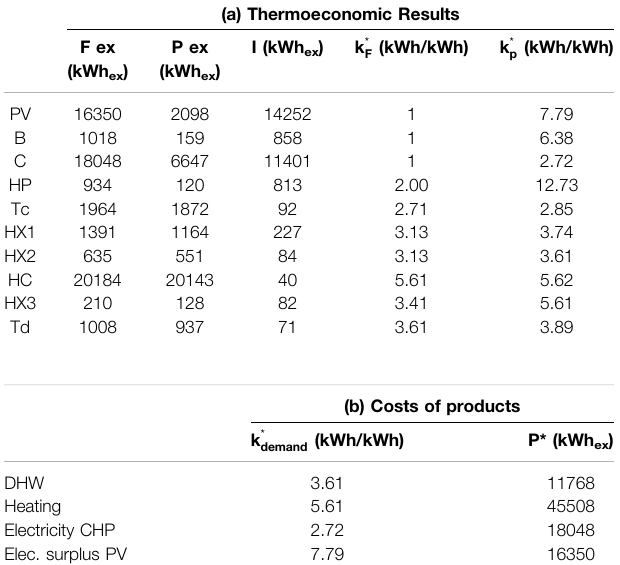
TABLE 4A | Thermoeconomic results (a) of real components (b) of